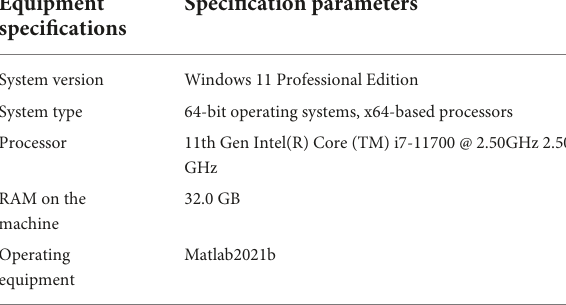
TABLE 4 Description of the experimental environment.